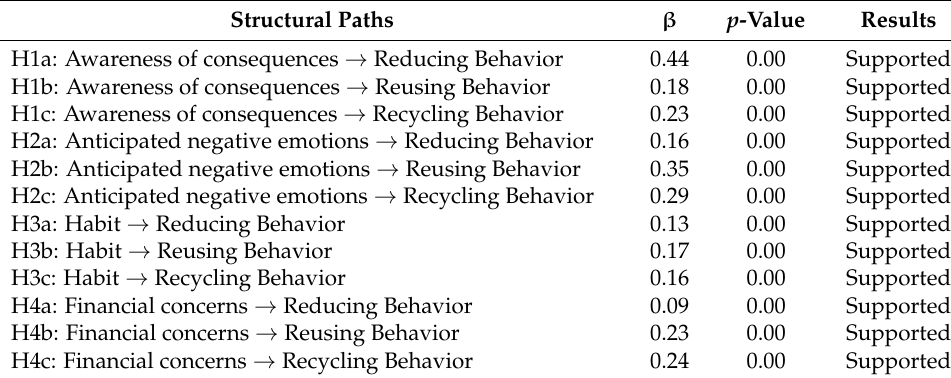
Table 5. Analysis of